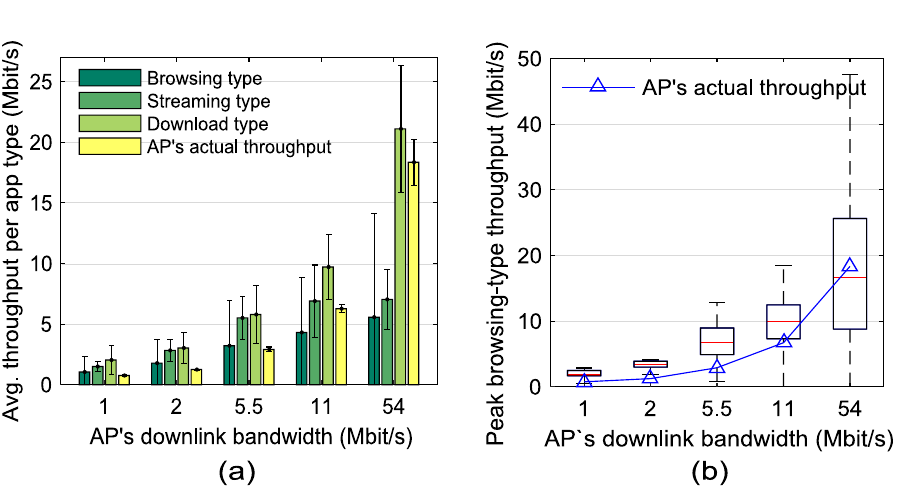
Fig 4. Average and peak throughput. (a) averages of the throughput and their standard deviations when applications of browsing, streaming, and download types were used. (b) Peak throughput of browsing-type applications.